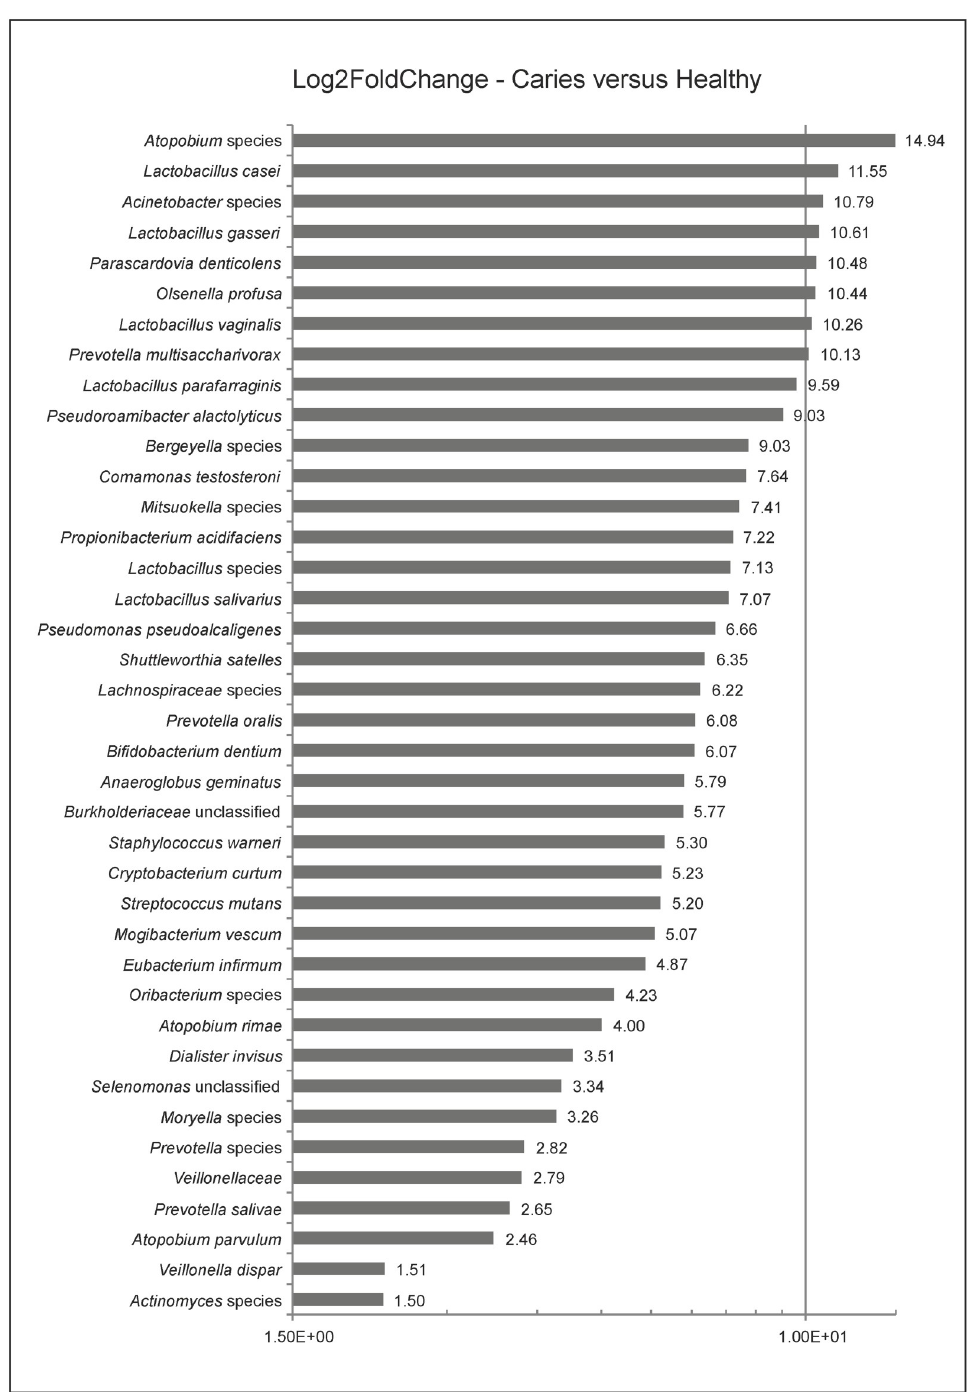
Fig 7. Differences in microbiome composition. Log2FoldChange bar charts of linear discriminant analysis effect size (LEfSe) using the distinctive parameter “class” to test for OUT differences.